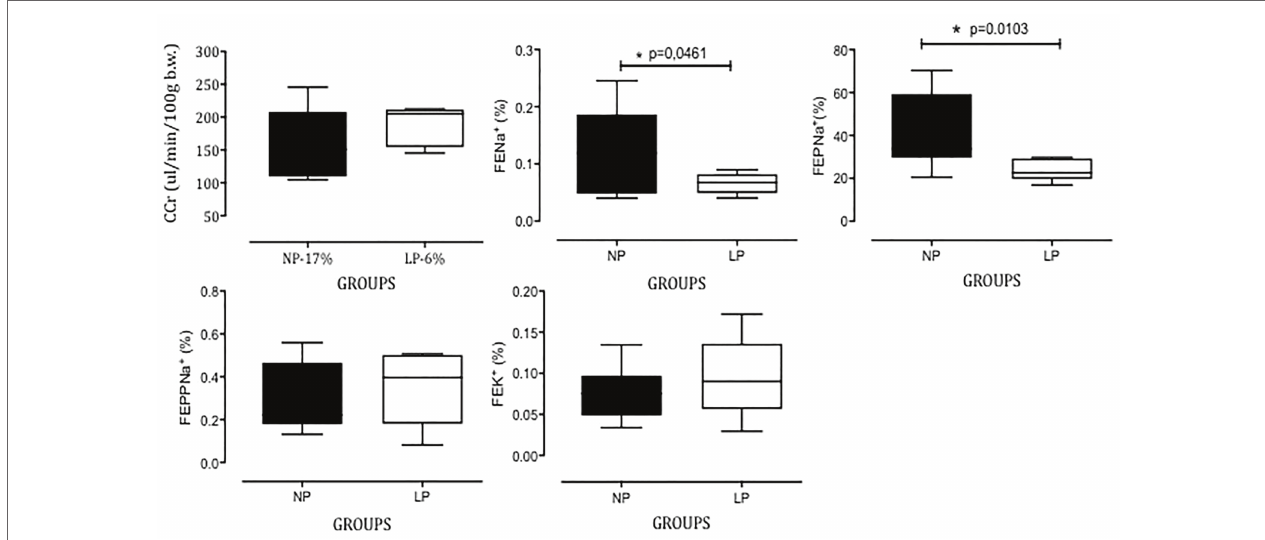
FIGURE 4 | Renal function; creatinine clearance ( C Cr), fractional sodium excretion (FENa+), proximal (FEPNa+), and post-proximal (FEPPNa+) fractional sodium excretion, and fractional potassium excretion (FEK+) in 16-week-old LP offspring ( n = 11) compared to age-matched NP progeny ( n = 15). Data are presented as boxes and whiskers (minimum and maximum values); unpaired Welch’s t -test was used for data analysis. The level of significance was set at p <